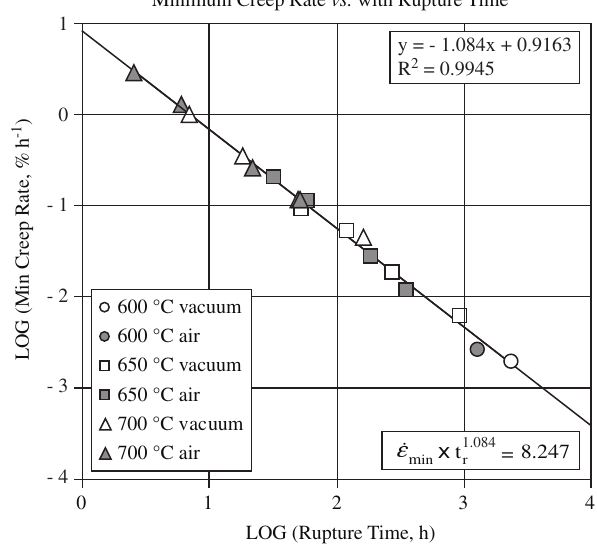
Stress vs. Rupture Time